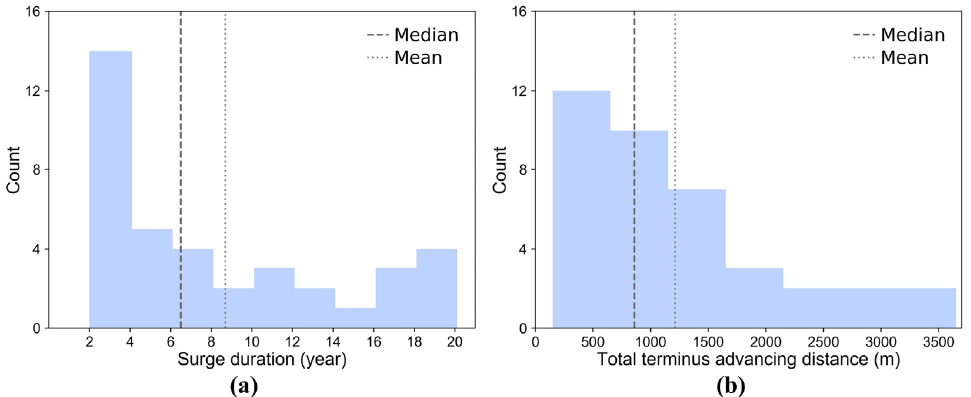
Figure 9. Distributions of ( a ) surge durations and ( b ) total terminus-advancing distances of the 38 clean-ice or partly debris-covered glacier-surging events.